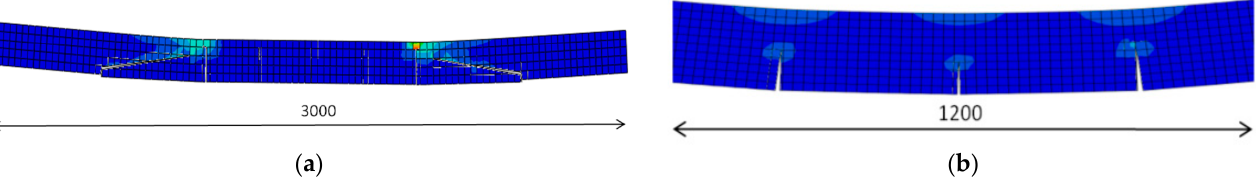
Figure 14. Crack distributions of composite slabs in tests.